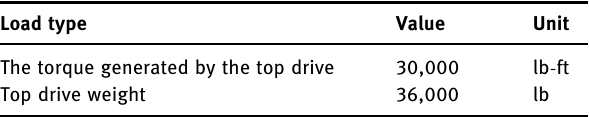
Table 1: The boundary condition for the fi xture